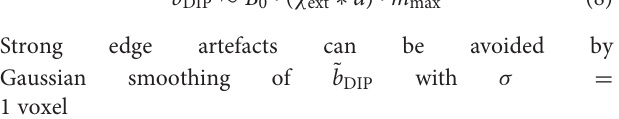
1. Iterative correction loop (step counter j , ˜ b bg,0 : = 0, ϕ bg,0 = 0) (a) Field Mapping: Spatial unwrapping of the phase in each echo (Abdul-Rahman et al., 2007), mod 2 π within m max ; temporal unwrapping in a central reference point; linear regression. (b) Phase Masking: